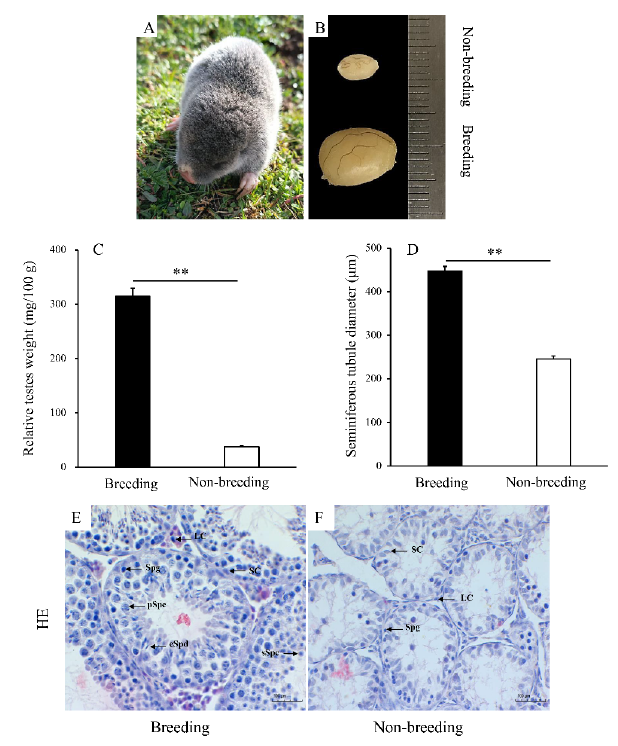
Figure 1. The testicular morphology, weights, and histology of plateau zokor ( Eospalax baileyi ) during the transition from the breeding to the non-breeding season. ( A ): the plateau zokor, ( B ): the testes after fixation, ( C ): the relative testes weight of plateau zokor during the breeding and the non-breeding seasons, ( D ): the seminiferous tubule diameter of plateau zokor during the breeding and the non-breeding seasons, and ( E , F ): the histological change of the testes from the breeding season ( E ) to the non-breeding season ( F ). Scale bars, 100 µ m. SC, Sertoli cell; LC, Leydig cell; Spg, spermatogonia; pSpc, primary spermatocyte; sSpc, secondary spermatocyte; eSpd, elongated spermatid. Bars represent the means ± SD of two independent experiments ( n = 10 per season). Means within the columns with different marks indicate a significant difference; ** represents p <